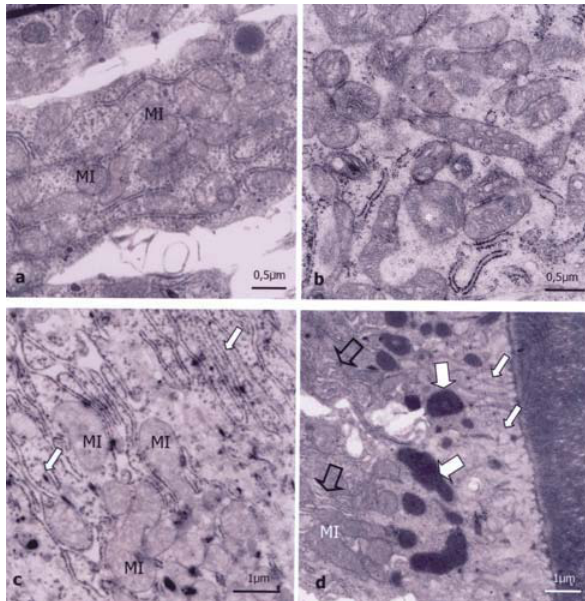
FIGURE 3 (a-d)- Ultrathin section of the secretory and maturation ameloblast of rat incisor buds. Observe: a) Preserved mitochondria (MI) of the smooth-ended ameloblast of 0 ppm group at the age of 7 days, b) At the basal region of the secretory ameloblast of newborn rat from the 100 ppm group, most mitochondria (*) are dilated with crests that are less organized than those of the control group, c) At the apical portion of ruffled-ended ameloblasts from rats of 100 ppm group at the age of 14 days, large amount of dilated mitochondria (MI) and preserved RER cisterns (arrow); d) At the apical region next to the matrix of smooth-ended ameloblasts of rats of the 100 ppm group at the age of 7 days, there are preserved RER cisterns (empty arrows), mitochondria (MI) and increased endocytic light microvesicles (small arrows) and big endocytic vacuoles (large